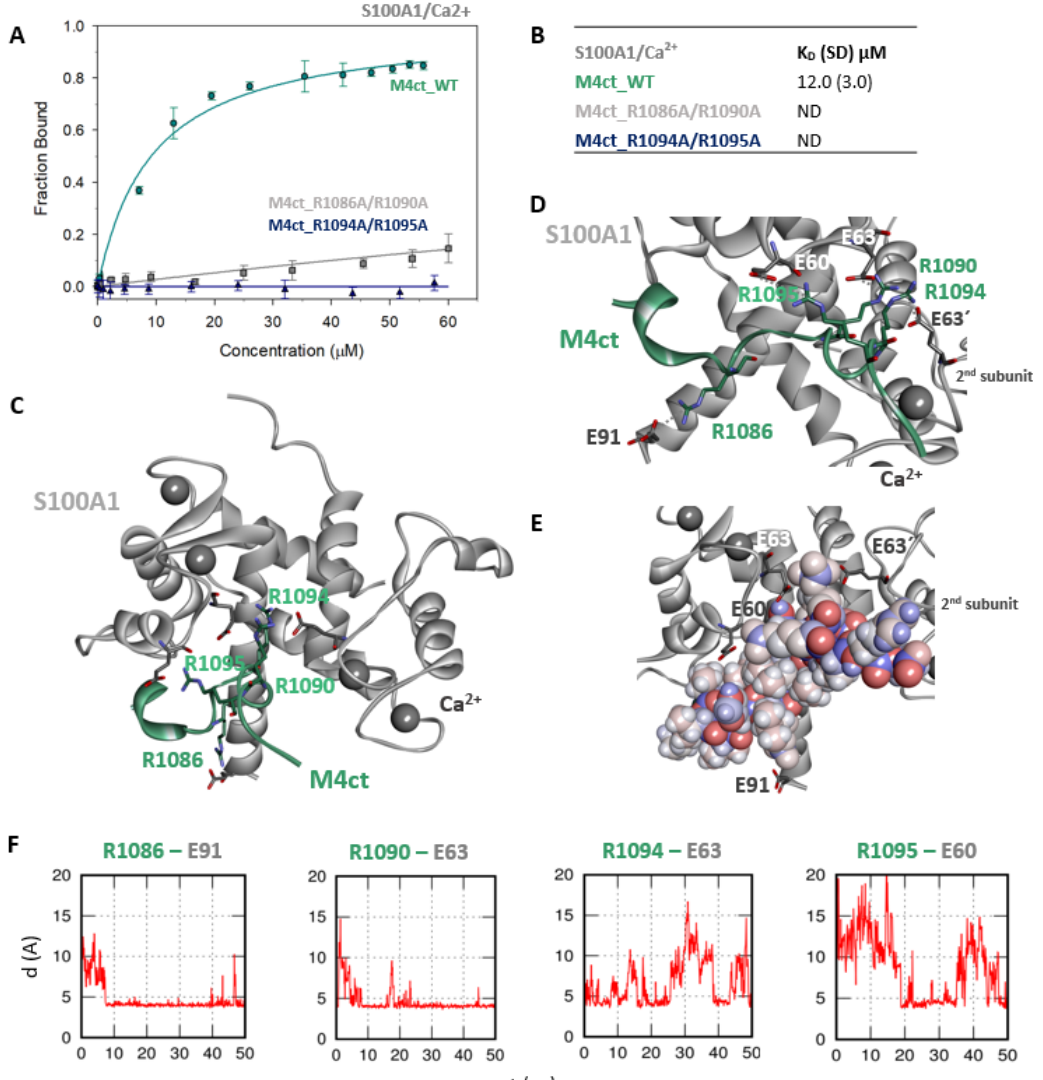
Figure 5. The M4ct / S100A1 complex. ( A ) The F B of fluorescently labelled M4ct_WT (circles), M4ct_R1086A / R1090A (squares) and M4ct_R1094A / R1095A (up-triangles) as a function of S100A1 (grey) concentrations. M4ct peptides were titrated by S100A1, and F B was calculated according to Equation (1); the solid lines represent the best fit to the binding isotherm from Equation (2) (Methods). ( B ) The equilibrium K D of the M4ct-binding epitope in complexes with S100A1 obtained by steady-state FA. ( C ) M4ct / S100A1 in the context of the whole S100A1 in the presence of Ca 2 + as a result of MDs. The side chains of M4ct (ribbon representation, green colour) with displayed R1086, R1090, R1094 and R1095 basic residues involved in the interaction with S100A1 (ribbon representation, grey colour). ( D ) The M4ct / S100A1 complex in detailed view; the binding partners are shown in the same representation as in Figure 5C, with salt bridges in atomic detail displayed as sticks: R1086-E91, R1090-E63, R1094-E63 and R1095-E60 and R1090- and R1094-E63´ of the 2nd monomer. ( E ) The M4ct / S100A1 complex in detailed view; M4ct is shown in CPK (partial charge colouring) representation, S100A1 displayed with E60, E63 and N72 of the 1st monomer and E63´ of the 2nd S100A1 monomer, with negatively charged residues (sticks representation, grey colour) involved in the interactions with M4ct. Ca 2 + displayed in a ball representation, grey colour. ( F ) Time-dependent geometry characteristics of the studied salt bridges R1086-E91, R1090-E63, R1094-E63 and R1095-E60 from MD simulations. A stable salt bridge is expected to have a distance of about 5Å between the termini of oppositely charged amino acids.